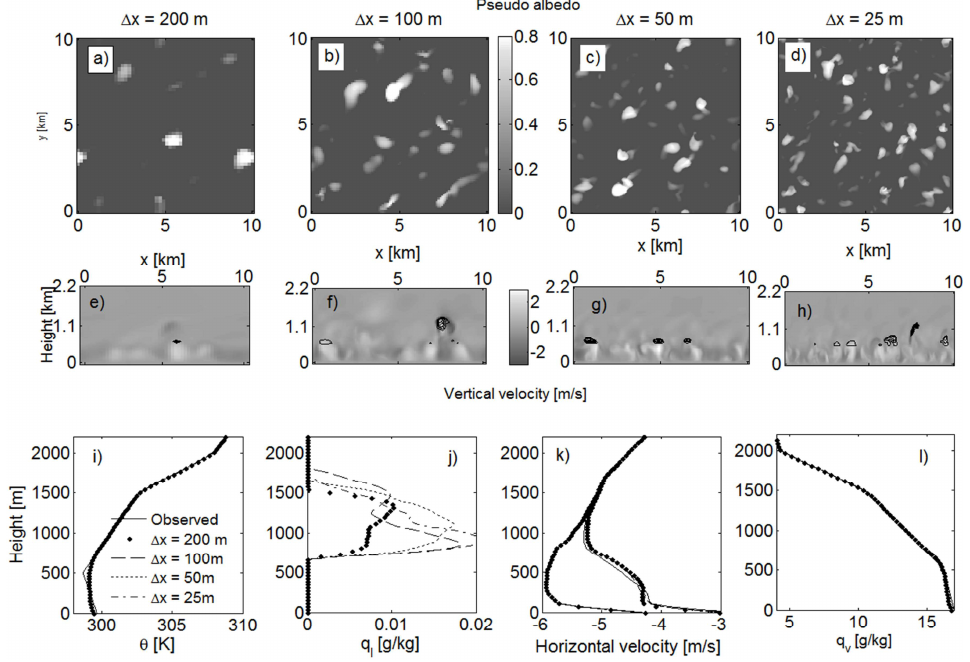
Figure 9. Same as Fig. 8, for cumulus cloud simulated by 3DCLOUD with assimilation of meteorological profiles based on the BOMEX case. We let 3DCLOUD iterating until 2h-simulation is done.